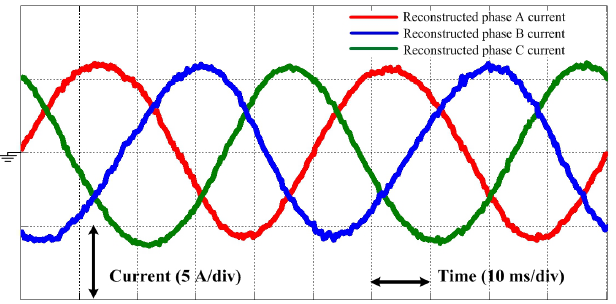
Figure 14. Reconstructed three-phase currents under the proposed phase current reconstruction method; time scale: 10 ms/div.